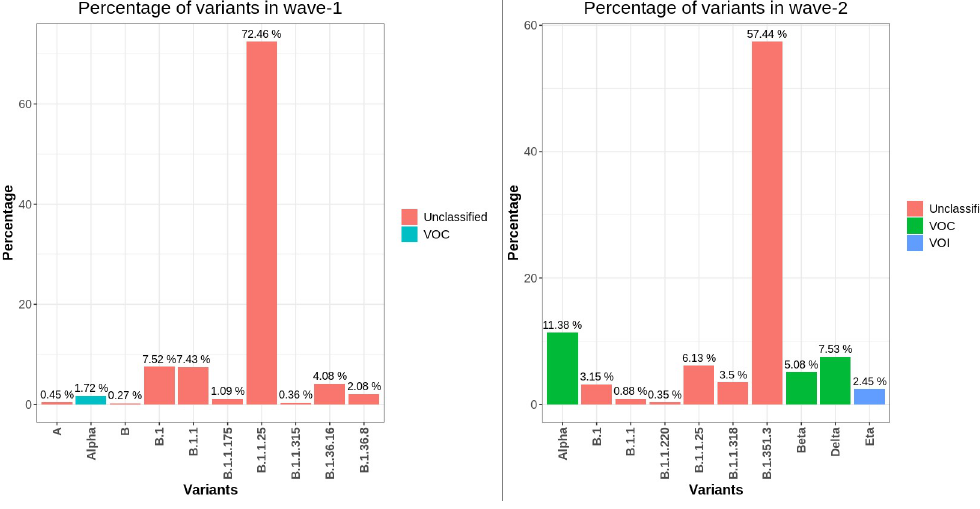
Fig 8. Prevalence of different variants (in percentage) observed in wave-1 and 2 of COVID-19 pandemic in Bangladesh. Almost all SARS-CoV-2 variants of wave-1 were from B lineage. On the other hand, wave-2 had an increased number of VOC variants. The most prevalent B.1.351.3 variant of this wave is a derivative of the beta (B.1.351) variant.